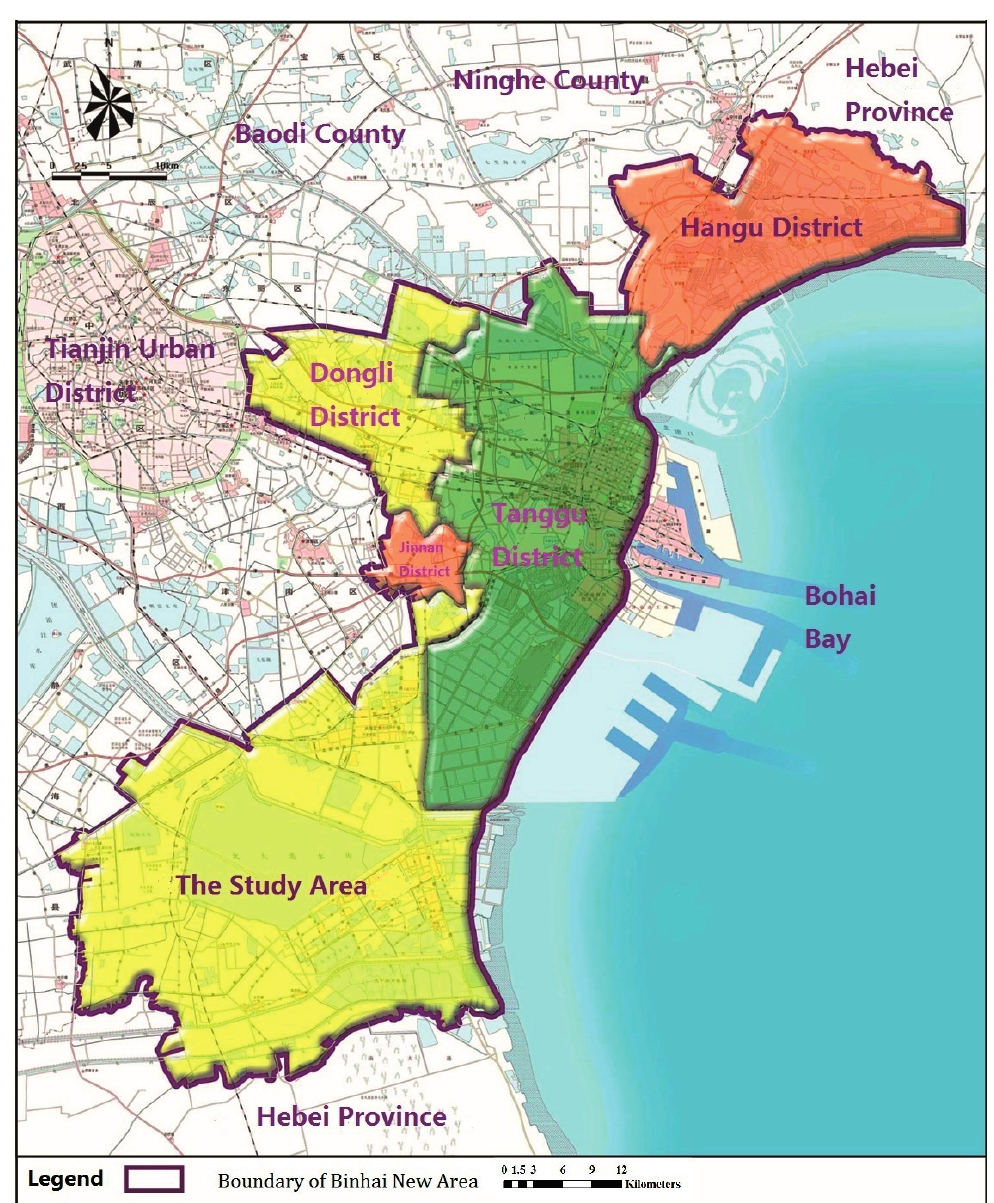
Figure 1. Location and scope of the study